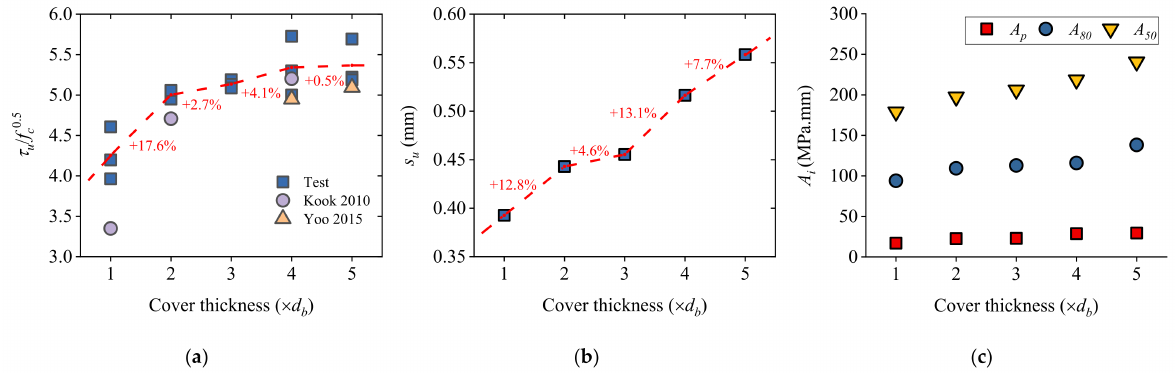
Figure 10. Effect of cover thickness on bond performance: ( a ) bond strength; ( b ) peak slip; ( c ) bond